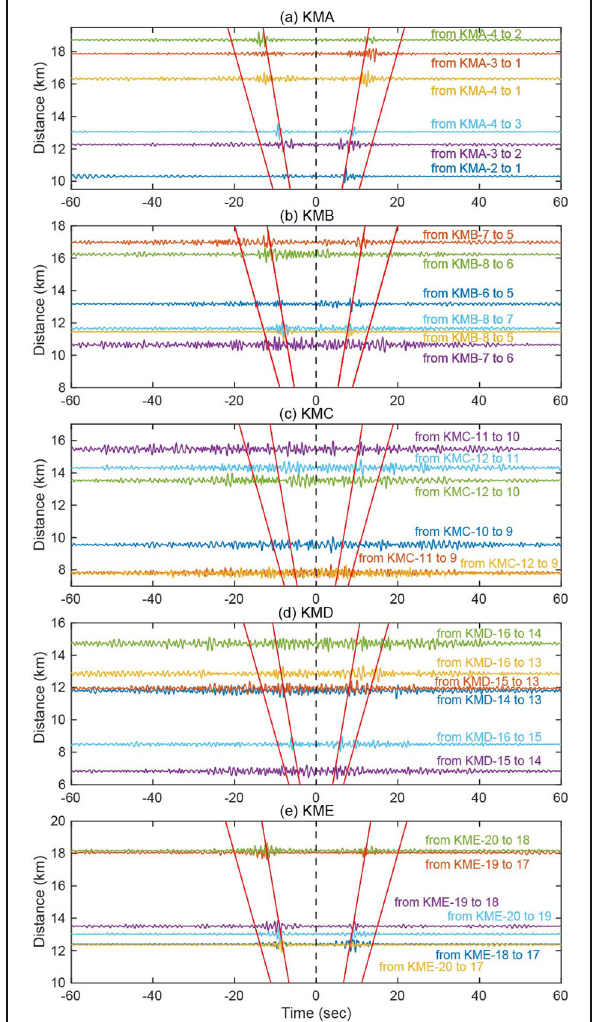
Fig. 2 Reference cross-correlations between station pairs within the five DONET1 nodes. Each node is labeled with the station pair and the propagation direction in positive time. The red lines represent velocities of 0.9 km/s (outer pair) and 1.5 km/s (inner pair). a KMA. b KMB. c KMC. d KMD. e